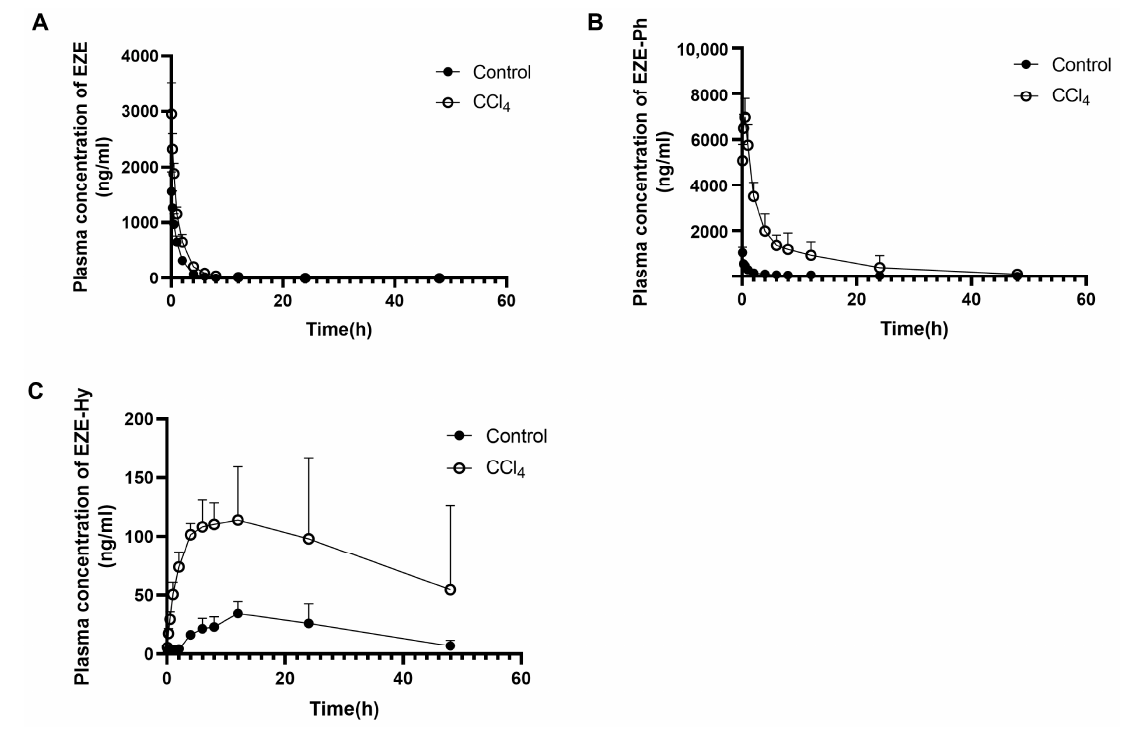
Figure 3. Mean plasma concentration–time profiles of EZE ( A ), EZE-Ph ( B ), and EZE-Hy ( C ) following intravenous administration of 10 mg/kg of EZE to control and CCl 4 -induced rats. Each point was presented as mean ± S.D. ( n = 5).